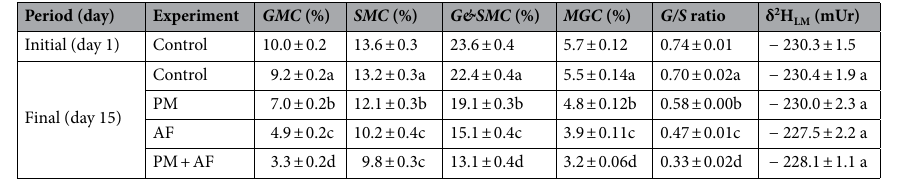
Table 1. Variations of the lignin monomer content, methoxy group content, monomer ratio, and δ 2 H LM values in the bulk material and degradation residues from the beginning of biodegradation to the end. Experiments: Control, uninoculated control; PM, Pseudomonas mandelii ; AF, Aspergillus fumigatus ; PM + AF (P + A), co-culture of the two microbes. GMC , guaiacyl (G-lignin) monomer content; SMC , syringyl (S-lignin) monomer content; G&SMC , G&S-lignin monomer content; MGC , methoxy group content; G/S , GMC/SMC . Values of a parameter labelled with different letters differ significantly ( P < 0.05).